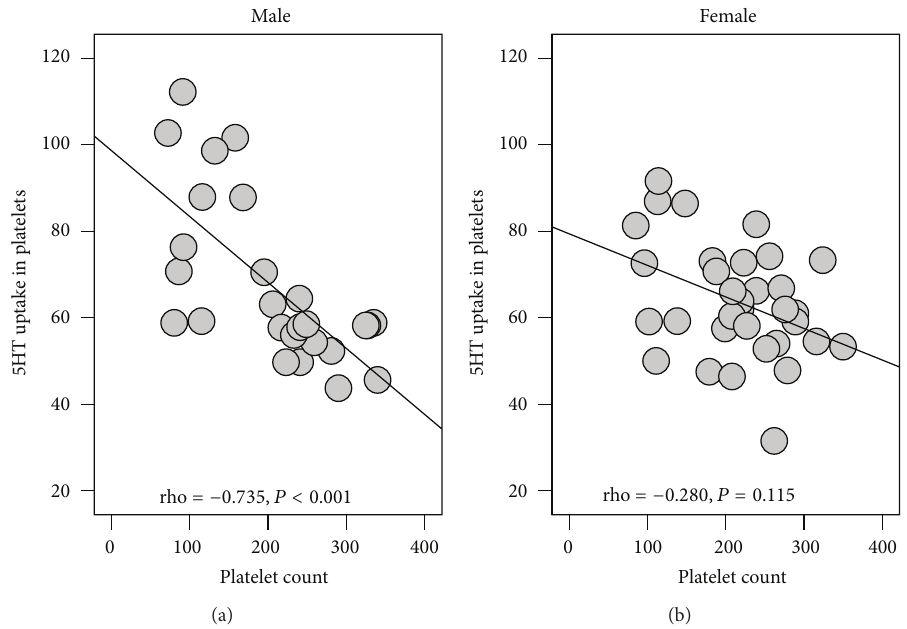
Figure 3: Relationship between blood platelet count and 5HT uptake rate in platelets of male and female patients with chronic hepatitis C. Note: 5HT uptake rate is expressed in pMol/10 9 plts . × 5 min and platelet count in × 10 9 plts./L blood. Table 3: Comparison of serotonin levels in platelets of healthy control subjects and patients with chronic HCV. 𝑛 Mean (SD) 95% CI